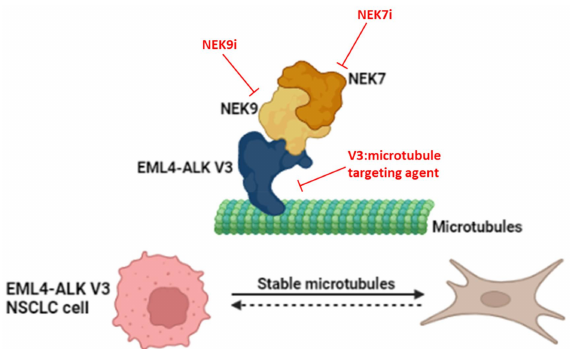
Figure 4. Potential therapeutic interventions based on the EML4-ALK V3/NEK9/NEK7 pathway. A cartoon illustrating how NEK9 is recruited to the microtubule network by EML4-ALK V3 and further recruits NEK7 forming the EML4-ALK V3/NEK9/NEK7 complex. The complex promotes increased cytoplasmic protrusions and enhanced migration in cells and potentially accelerated metastasis in patients. The use of targeted agents against the catalytic activities of NEK9 or NEK7, or that prevent assembly or microtubule recruitment of the complex, could potentially reverse these